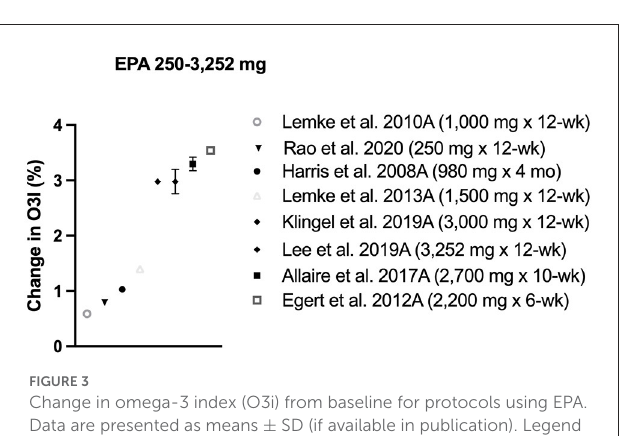
FIGURE3 Change in omega-3 index (O3i) from baseline for protocols using EPA. Data are presented as means ± SD (if available in publication). Legend shows dose and length of supplementation/fortification in parentheses.